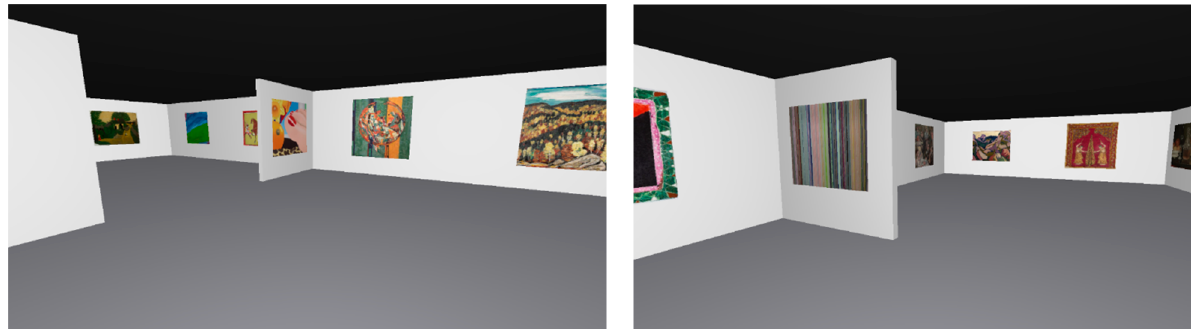
Figure 1. Screenshots from OGAR galleries created for the present